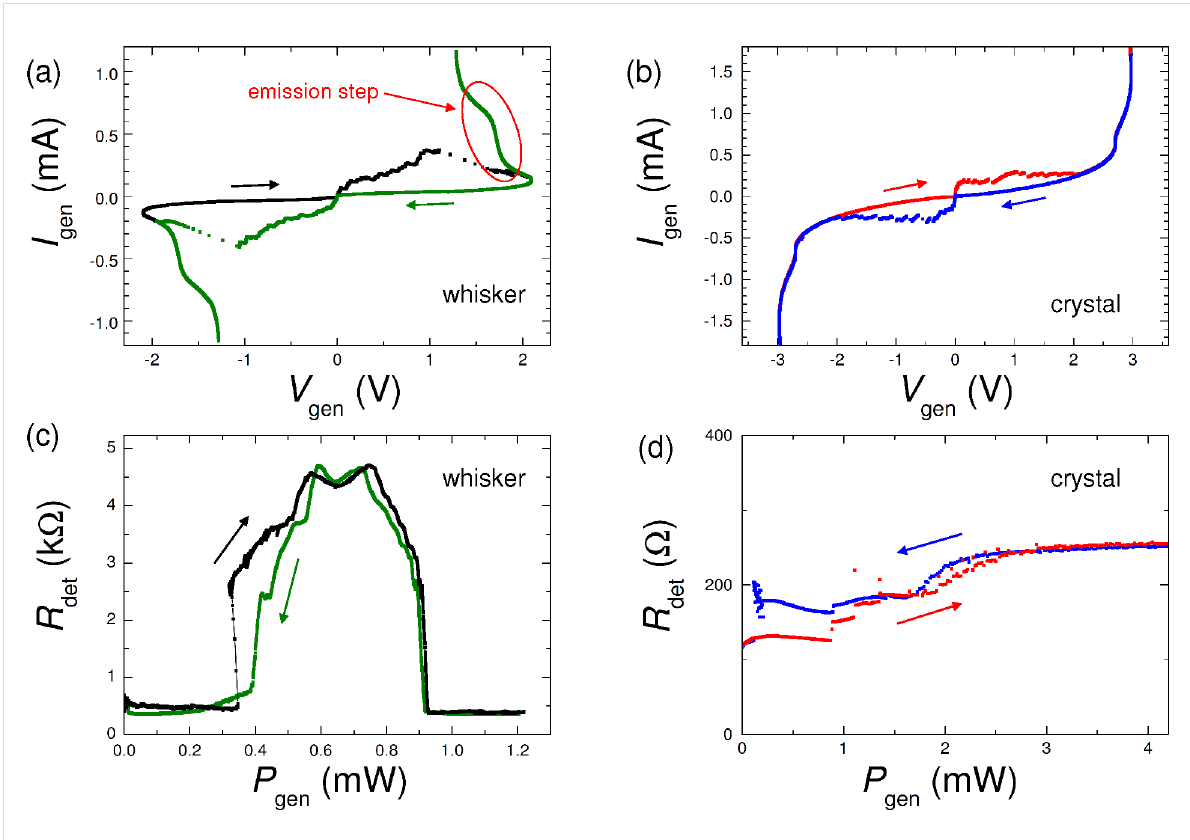
Figure 2: Current–voltage characteristics of mesa structures on (a) whisker- and (b) crystal-based devices. (c, d) On-chip generation–detection exper- iment for (c) whisker- and (d) crystal-based devices. Here, the ac resistance of the detector mesa is shown as function of the total dc dissipation power, P gen , of the generator mesa. For the whisker-based device (c) a profound emission occurs at the step in the I – V marked in panel (a). For the crystal-based device (d) only a small monotonic increment of R det vs P gen is observed, caused by gradual